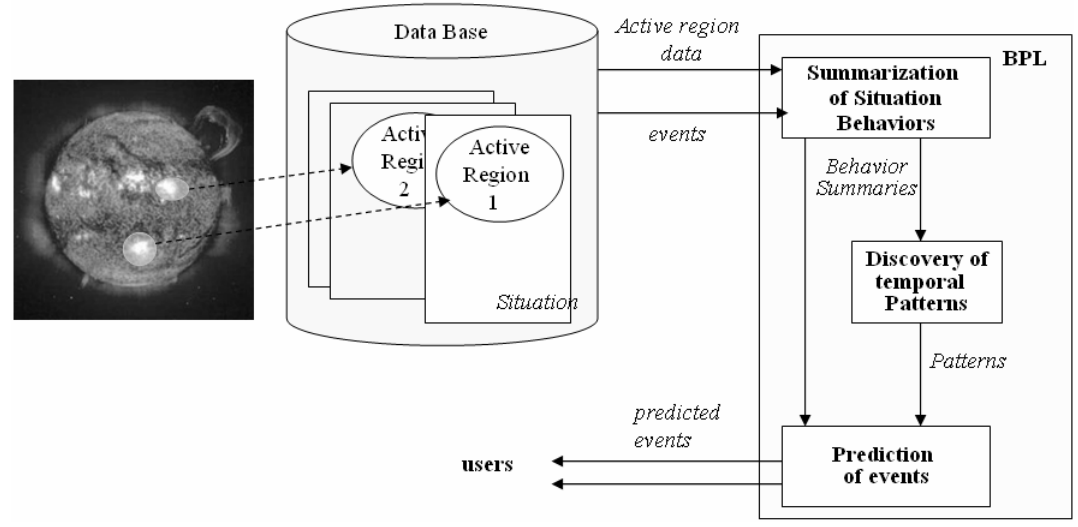
Fig. 1. Behavior Pattern Learning (BPL) Figure 1. Behavior Pattern Learning (BPL) processes.